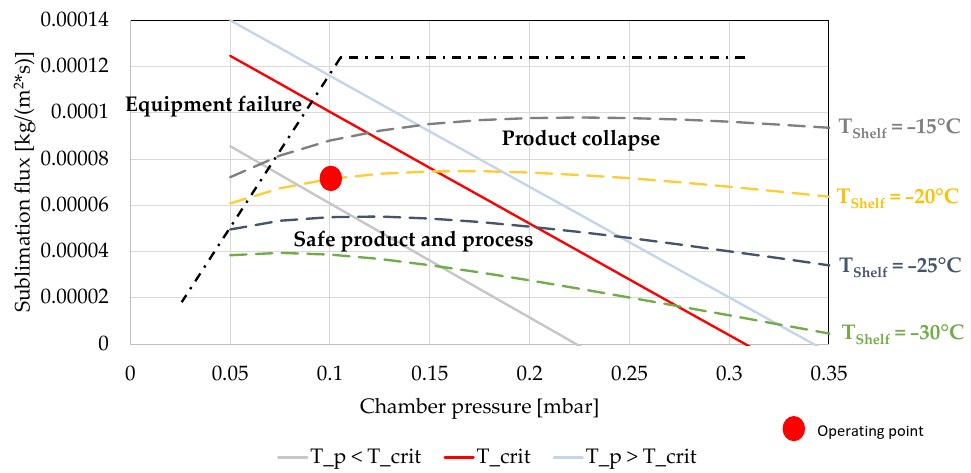
Figure 4. Exemplified Design Space (solid line: product temperature isotherms, dashed line: shelf temperature isotherms, dashed dot line: equipment constraint).